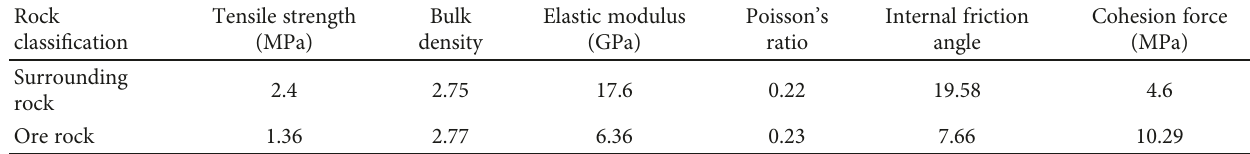
Figure 12: Stope model. Table 5: Model mechanical